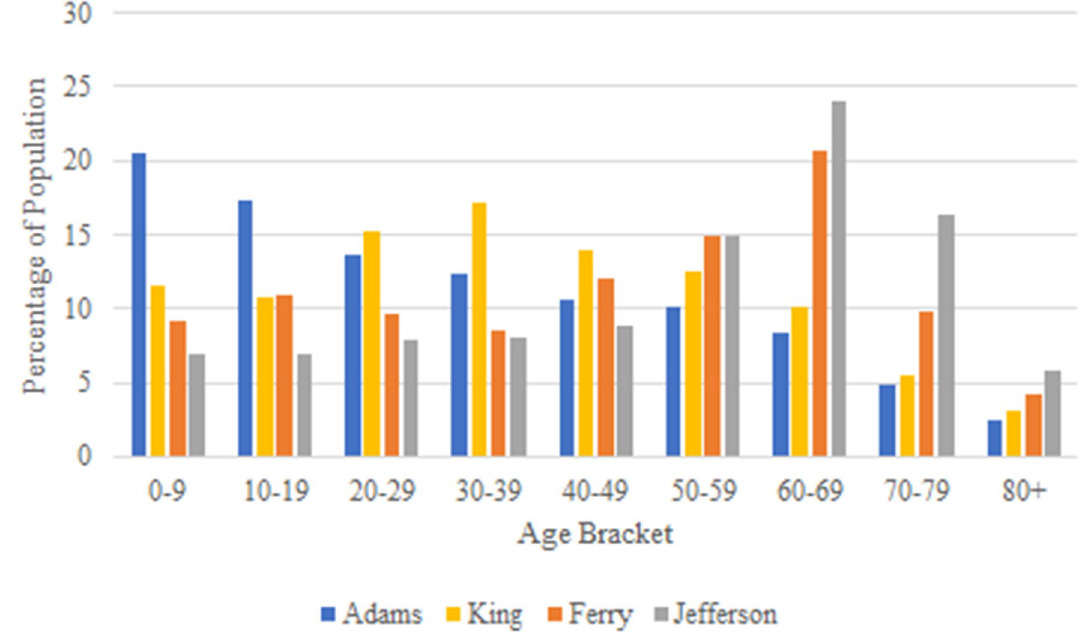
Figure 7. Age distribution of selected counties.